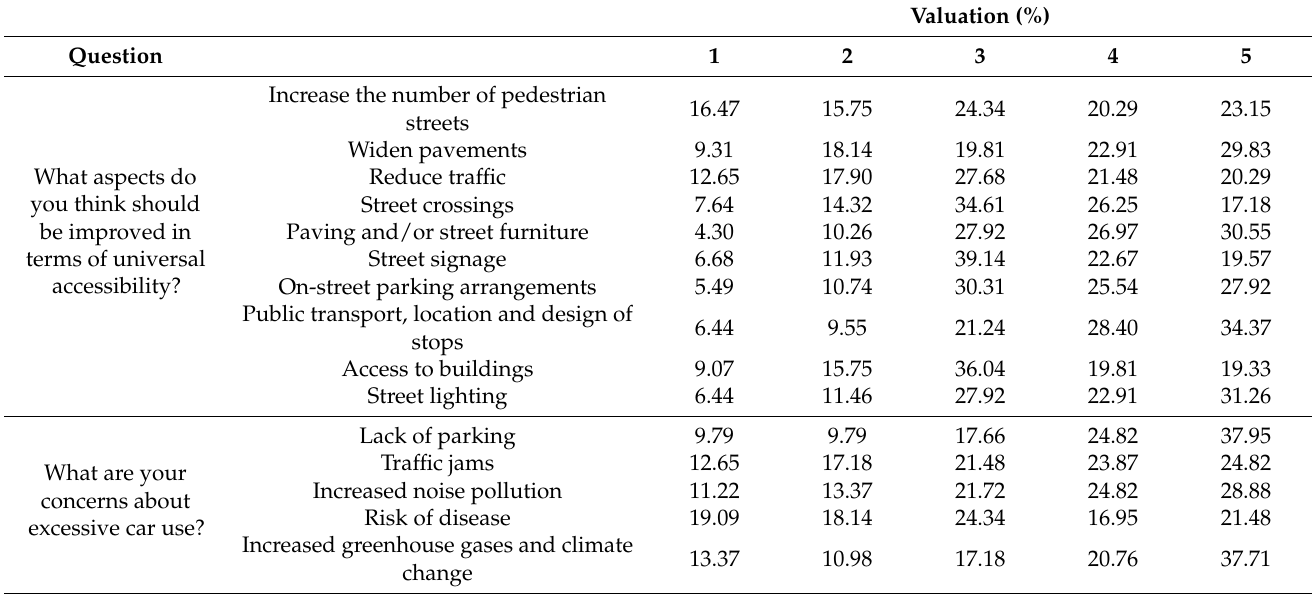
Table 5. Assessment of accessibility and the problem of excessive use of private